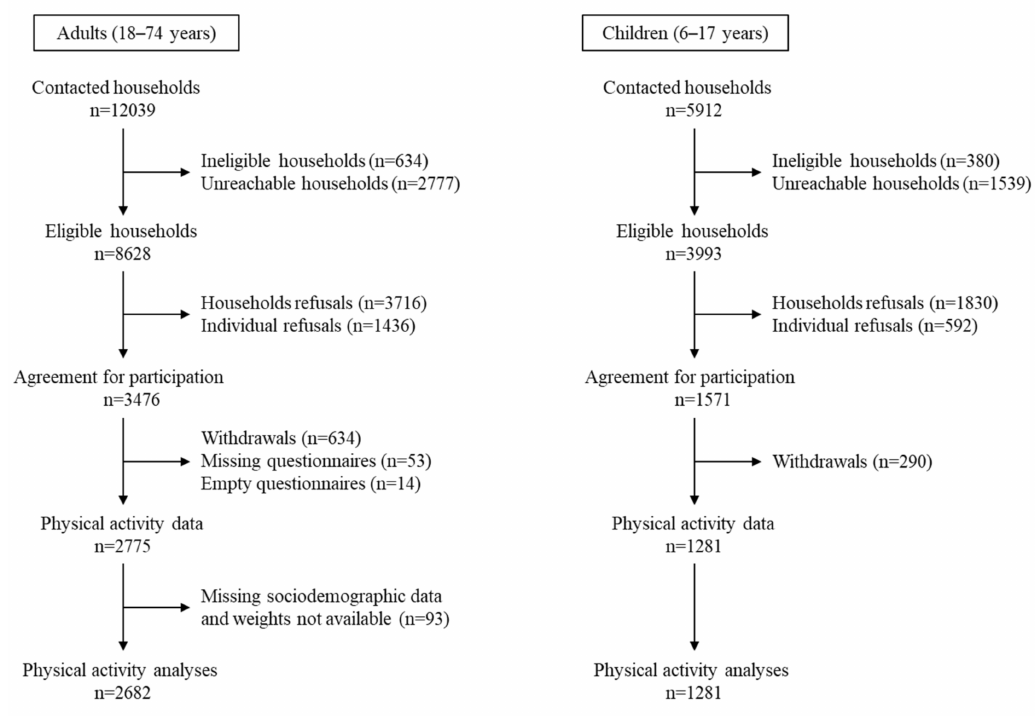
Figure 1. Flow diagram of inclusion—Esteban study